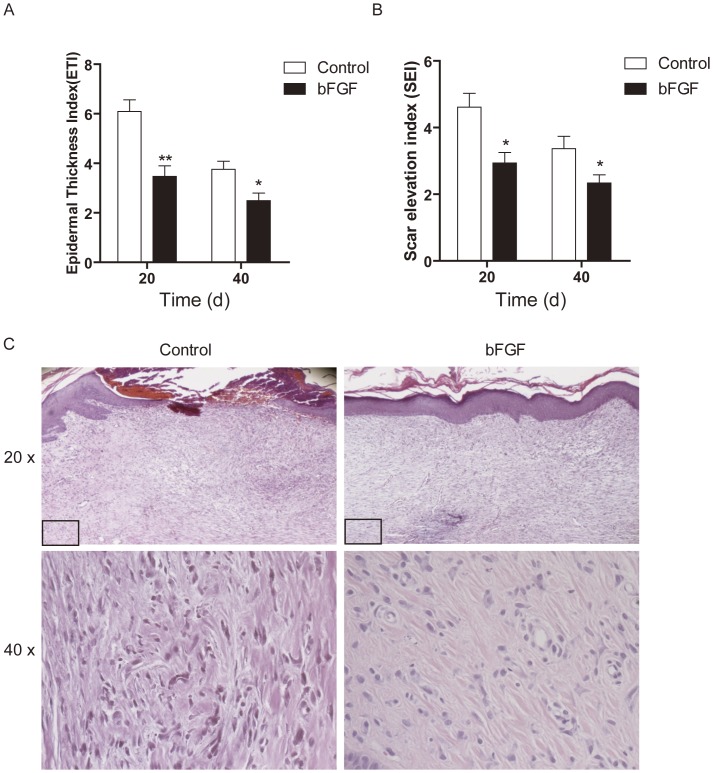
bFGF alleviated the scar formation in rabbit ear model.(A) The averaged Epidermal Thickness Index (ETI) of the scars. Epidermal hypertrophy was displayed by ETI. ETI >1 depicts a hypertrophic epidermis. (B) The averaged scar elevation index (SEI) of the scars. Dermal hypertrophy is displayed by the SEI, where SEI >1 depicts a hypertrophic scar. *P<0.05, **P<0.01 compared to control group, n = 6. (C) The microscopic histology of wounds that control or bFGF at day 40, HE stain.